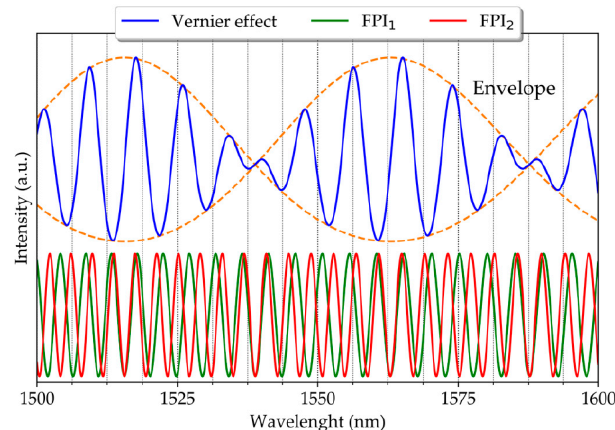
Figure 2. Vernier effect